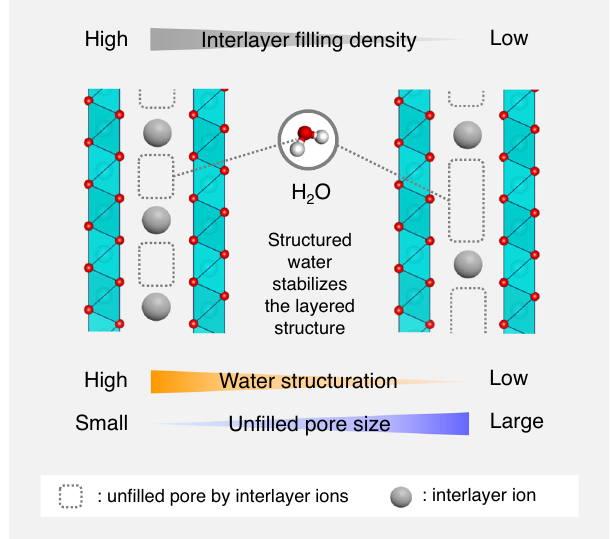
Fig.1|Schematicoftheinterlayerstructureinlayeredmetaloxide/hydroxides with different interlayer fi lling densities of ions. The high interlayer fi lling den- sity of ions results in small pores that are not fi lled by the interlayer ions; water is incorporatedandstructuredinthesepores.Thelowinterlayer fi llingregimeresults in large un fi lled pores. In all crystal structures, the green octahedra is MO 6 or M(OH) 6 ,andtheredandwhitespheresareoxygenorhydroxideionsandhydrogen atoms, respectively. The VESTA programme was used for visualising the crystal structures 15